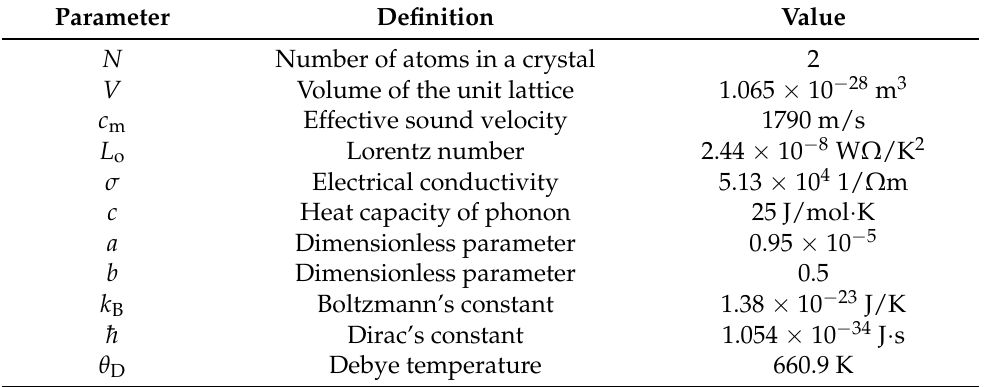
Table 4. Parameters of thermal conductivity.